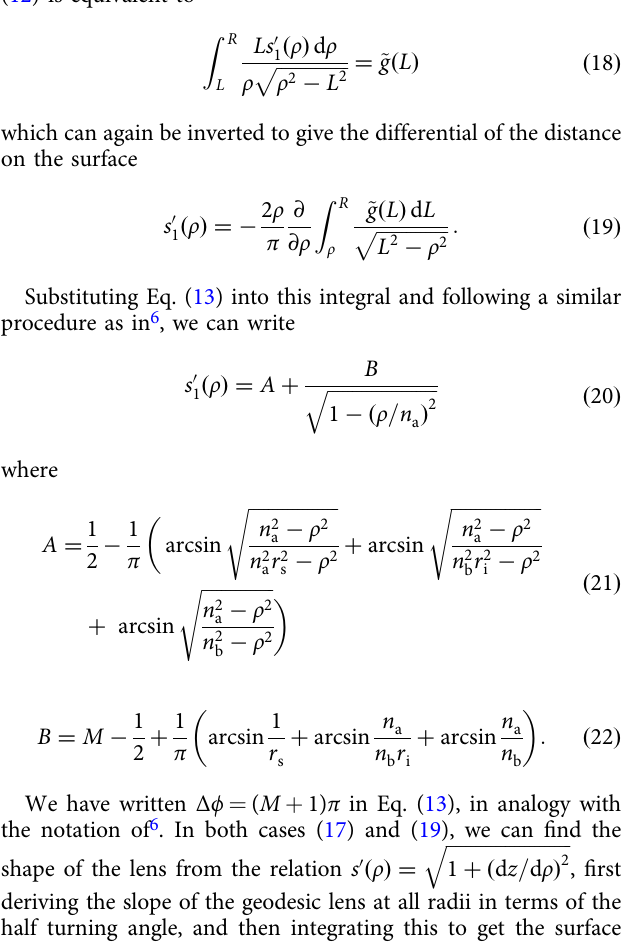
height z ( ρ ). Although in general z ( ρ ) cannot be analytically computed, the closed-form solution of s 1 ( ρ ) can be obtained for the case where the lower waveguide is fl at and has a homogeneous refractive index. Integrating Eq. (20) over ρ , the general solution of s 1 ( ρ ) is